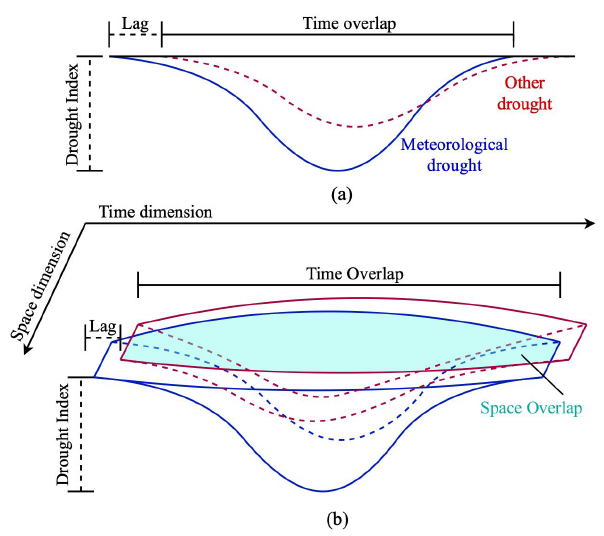
Figure 11. Conceptual graph depicting (a) traditional and (b) spa- tial and temporal connectivity rule of two drought